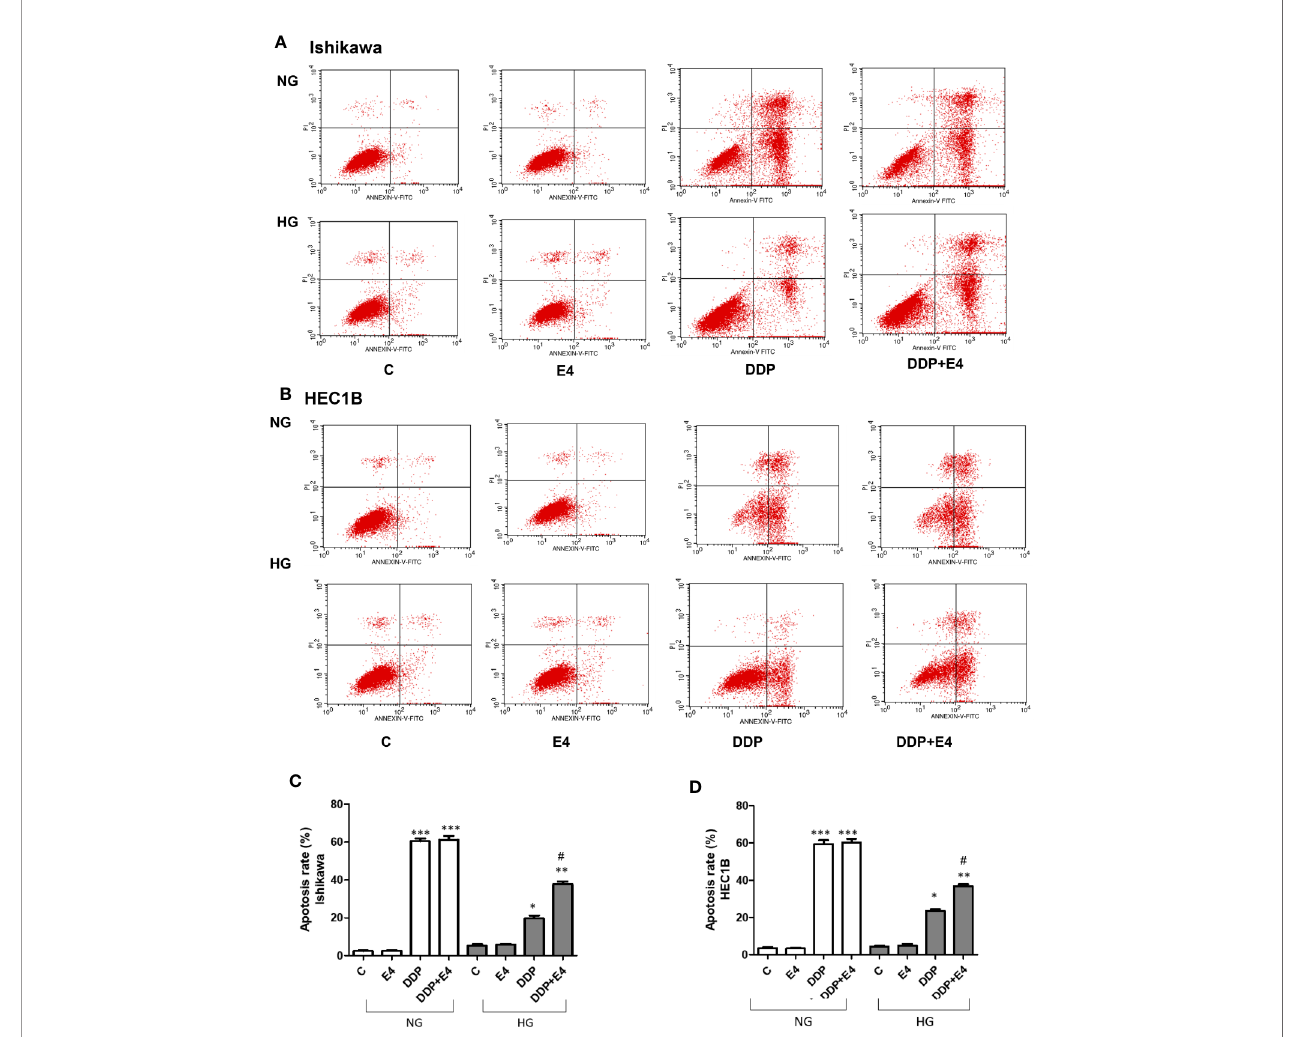
FIGURE 3 | Effects of Exe-4 in high glucose (HG) on cell apoptosis in the absence or presence of cisplatin (DDP) in human endometrial cancer (Ishikawa and HEC1B) cells. Cells were incubated for 48 h with Exe-4 (10 nM), DDP (25 µM), DDP (25 µM) + Exe-4 (10 nM), respectively, and apoptosis was detected by Annexin- V FITC/PI double staining. Measurements were performed in triplicate. ∗∗∗ p < 0.001 DDP (25ROS formed in triplicate TC/PI double staining cancer (Ishikawa and HEC1B) cells. ∗ p < 0.05 DDP (25 µM), ∗∗ p < 0.01 DDP (25µM) + Exe-4 (10 nM) vs . control group and Exe-4 (10 nM) in Ishikawa/HEC1B cells cultured in